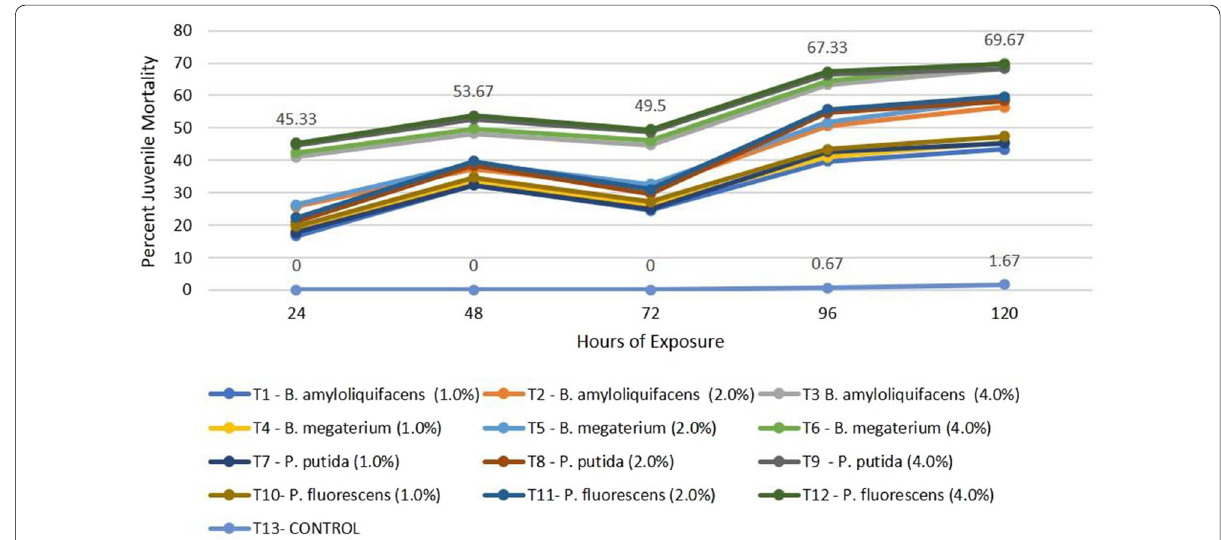
Fig. 2 In vitro effect of microbial formulations on second stage juveniles of Meloidogyne incognita